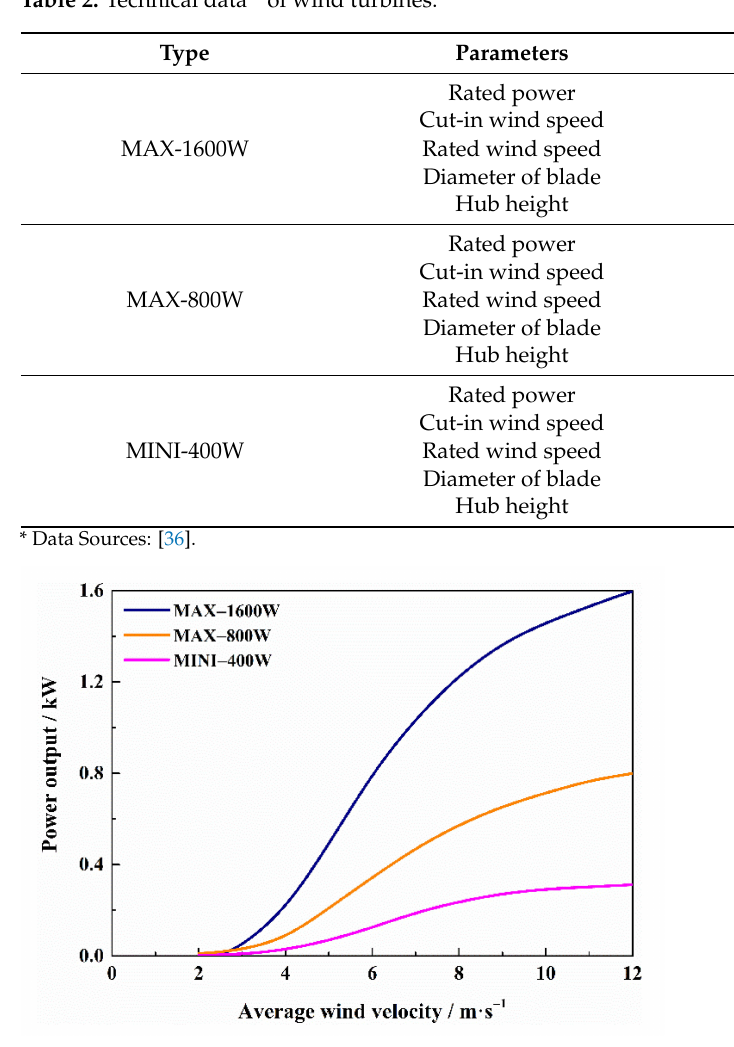
Table 2. Technical data * of wind turbines.